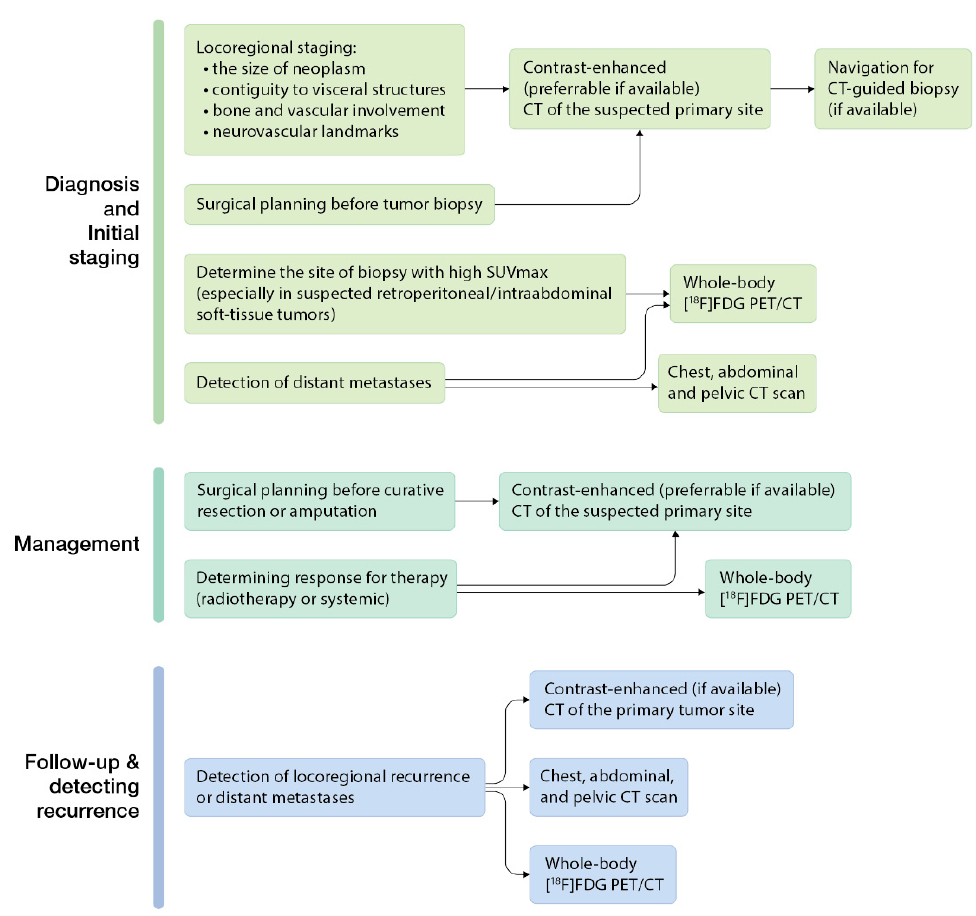
Figure 3. Available CT modalities for sarcoma diagnosis, management, and follow-up (based on The National Comprehensive Cancer Network guidelines [19,20]).